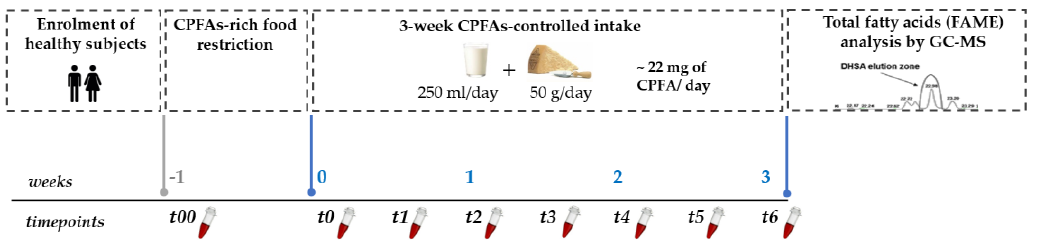
Figure 1. Graphical representation of the study design. CPFAs: cyclopropane fatty acids; DHSA: dihystrosterculic acid; FAME: fatty acids methylesters.